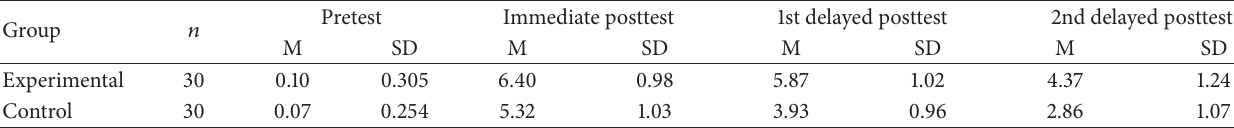
Table 5: Descriptive statistics for the productive vocabulary tests.